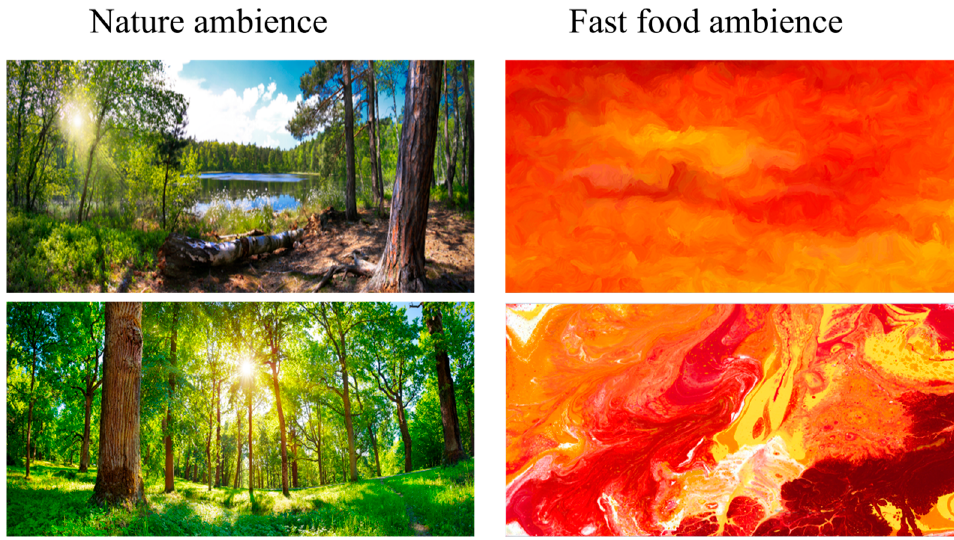
Figure 2. Image pairs chosen for the experimental ambiences.